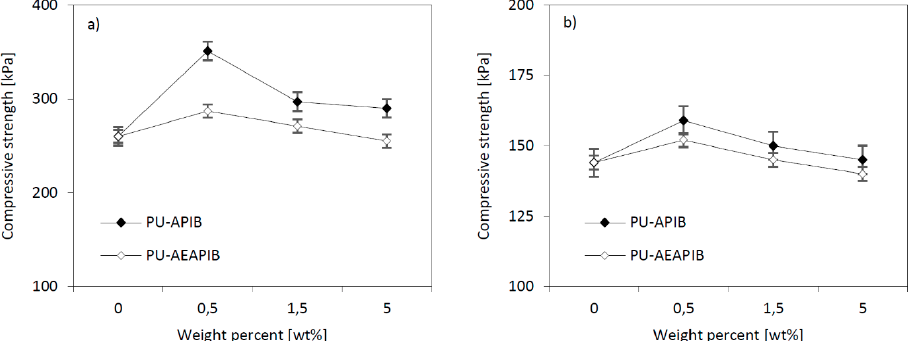
Figure 8. Effect of POSS content on the compressive strength of RPUFs measured ( a ) parallel and ( b ) perpendicular to the foam rise direction.